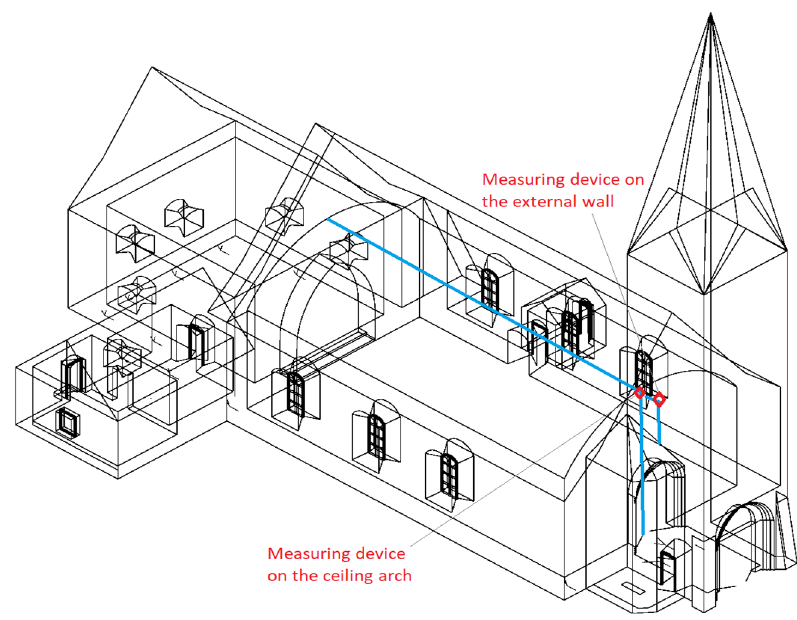
Figure 5. Krimulda church 3D model with locations of the measuring